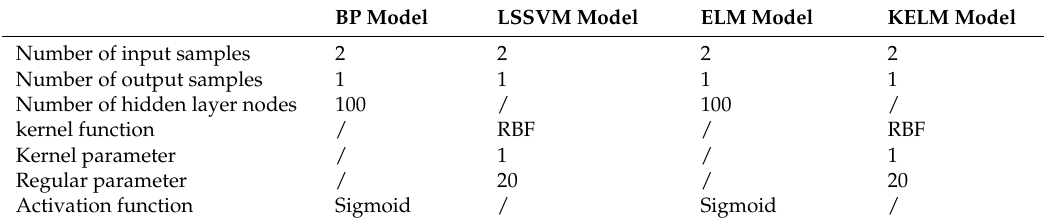
Table 2. The list of parameters for each model.